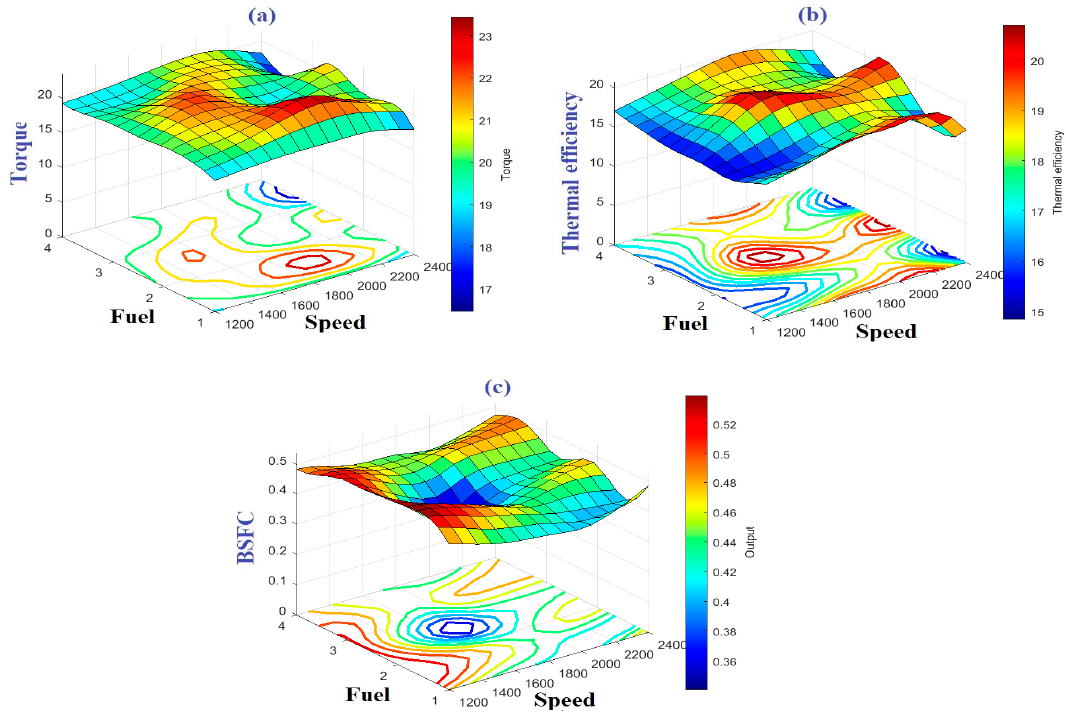
Figure 9. The 3D Surfaces of the fuzzy-based models, (a) brake torque, (b) brake thermal efficiency, and (c) BSFC. Note: Fuel (1 for diesel, 2 for palm oil, 3 for sunflower oil and 4 for corn oil).